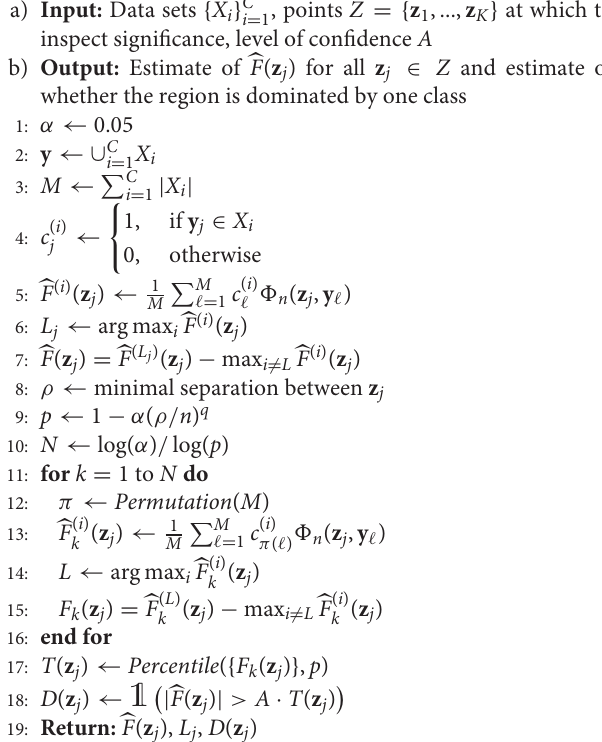
Algorithm 2: Algorithm for determining significance of class identifier function using label permutation. Along with returning F ( z j ) and D ( z j ), it also returns L j , which is the predicted class for z j b